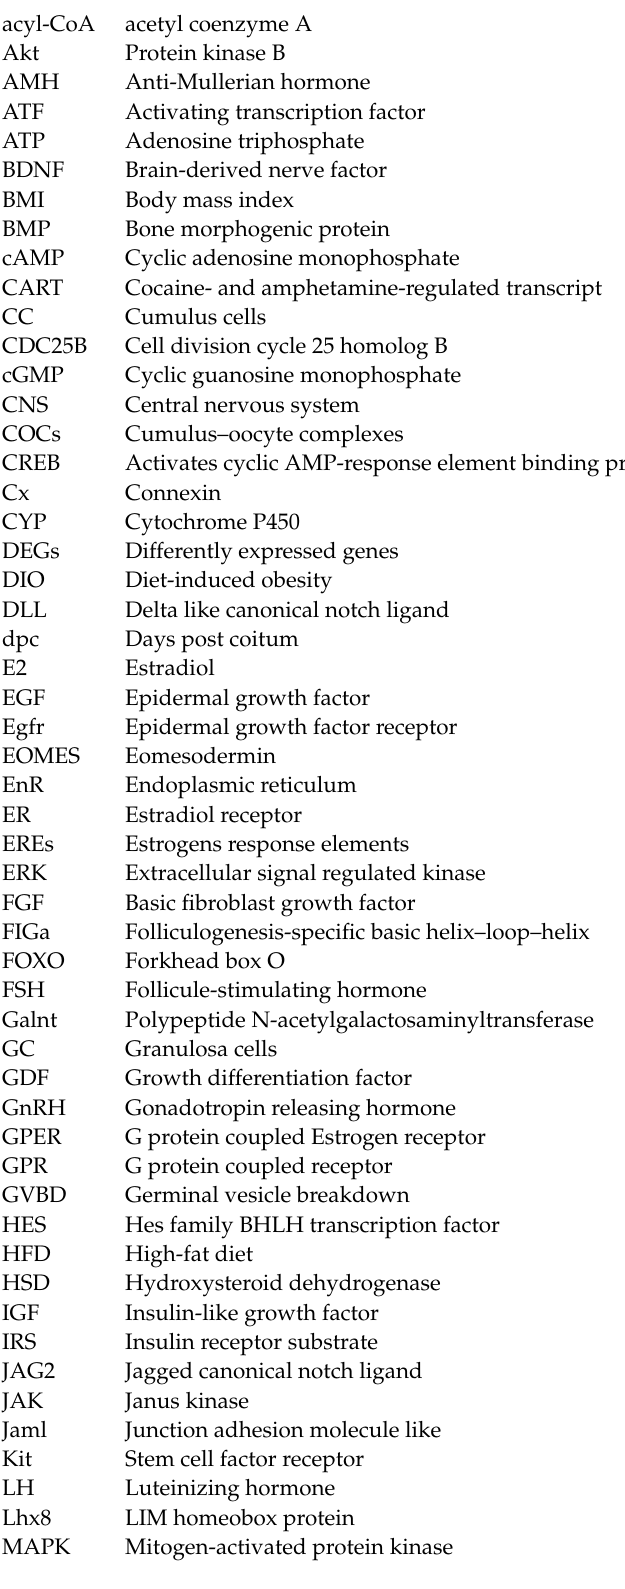
Folliculogenesis-specific basic